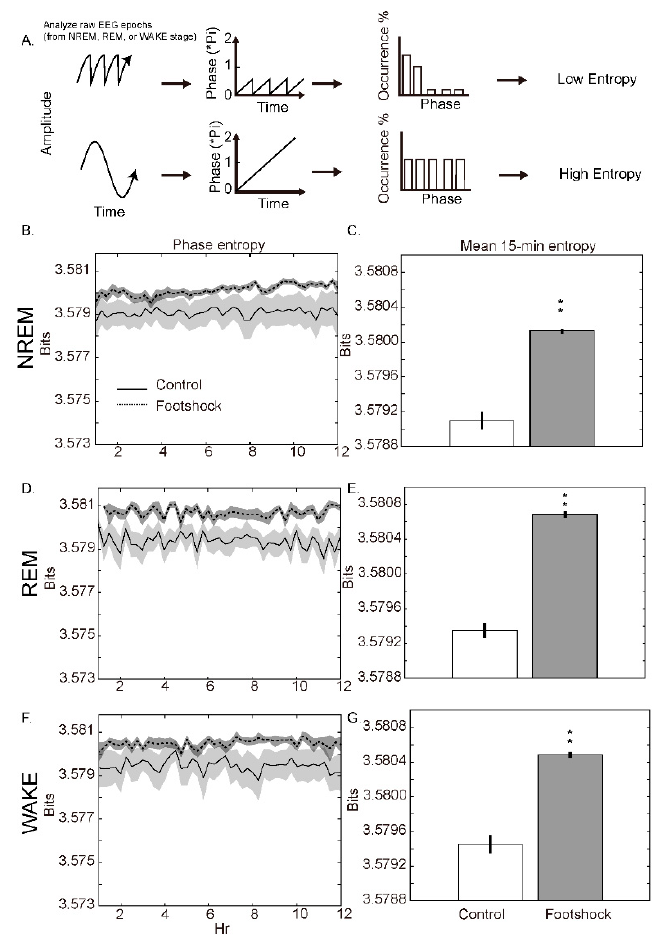
Figure 5. Comparison of the phase entropy after the footshock stimuli. ( A ) Abrupt and edge waveforms result in a low entropy whereas smooth sine-wave-like waveforms cause uncertainty of occurrence rate and results in a high entropy. ( B ) Distribution of phase entropy obtained from NREM sleep. Solid line and light gray shadow are the values of means ± SEMs for every 15 min of light period obtained from the control group. Dashed line and dark gray shadow are results acquired from the footshock group. ( C ) Statistical significant test for the phase entropy. White bar is the value of mean ± SEM for 15-min bins across the total of 12-h light period obtained from the control group and gray bar represents the phase entropy acquired from the footshock group. ( D , E ) represented the data of REM sleep. ( F , G ) demonstrated the results for wakefulness. ** Indicates the difference reaches statistical significance of p <